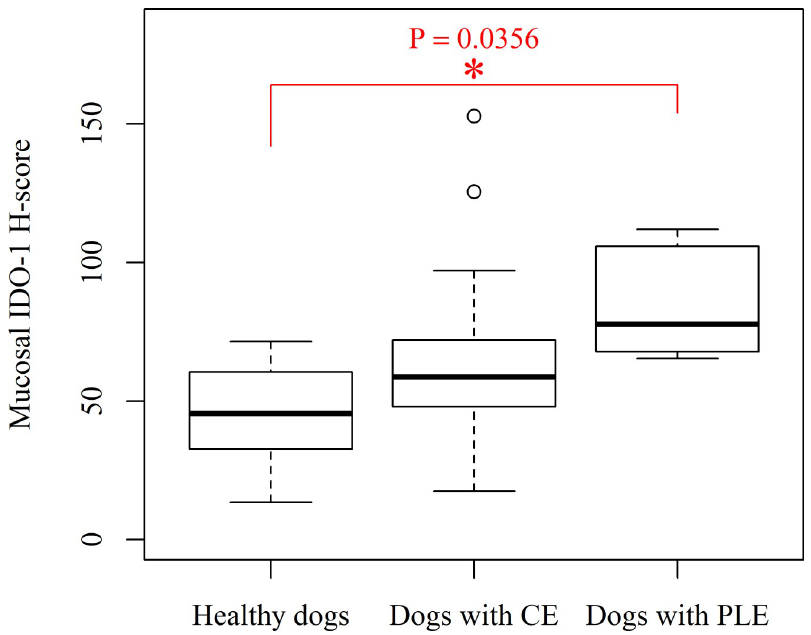
Fig 2. Box and whisker plot of mucosal IDO-1 H-score in the duodenum of dogs with protein-losing enteropathy (PLE), chronic enteropathy (CE) and healthy Beagle dogs. Dogs with PLE– 6 dogs, median– 77.66, interquartile range- 40.18. Dogs with CE– 18 dogs, median– 58.69, interquartile range- 26.82, healthy Beagle control dogs- 8 dogs, median– 45.26, interquartile range- 31.68. area per cell: SRCC = -0.89, P = 0.019, percentage mucosal IDO-1 positive: SRCC = -0.83, p = 0.042, mucosal IDO-1 H-score: SRCC = -0.94, P = 0.0048; Fig 5).